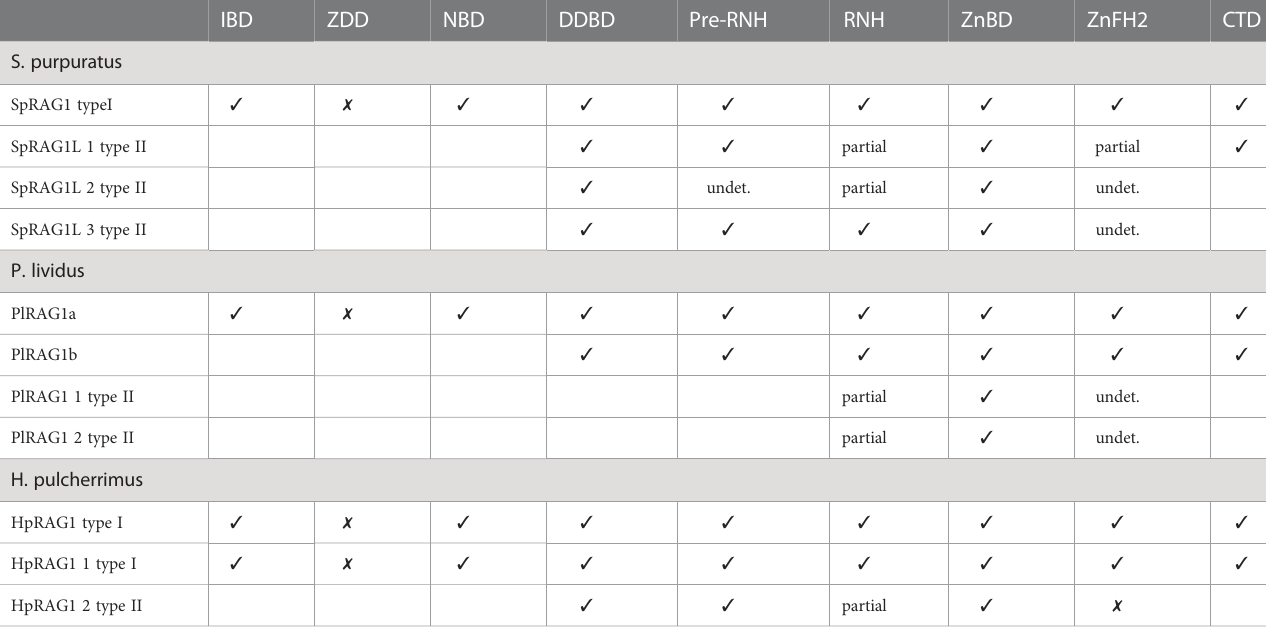
TABLE 1 Domains presence in the echinoid RAGL genes. IBD ZDD NBD DDBD Pre-RNH RNH ZnBD ZnFH2